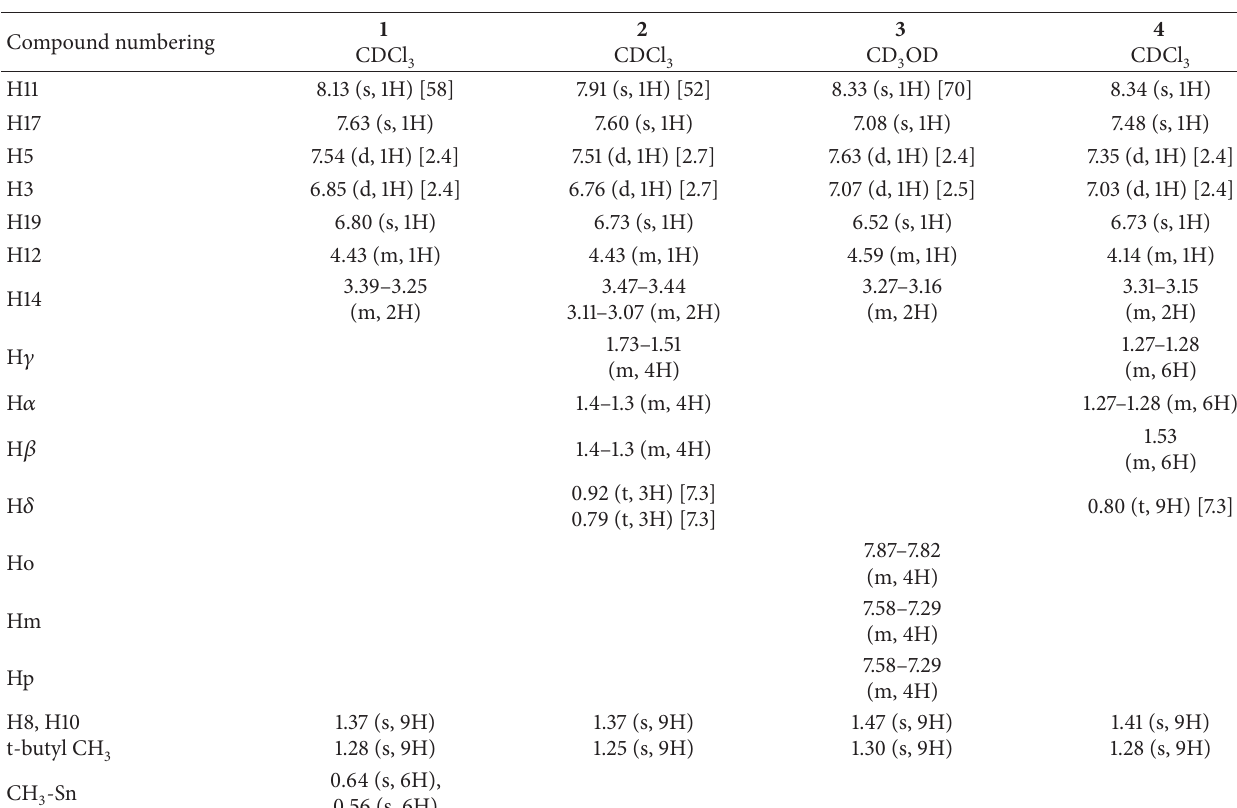
Table 1: 1 H NMR data of compounds 1 – 5